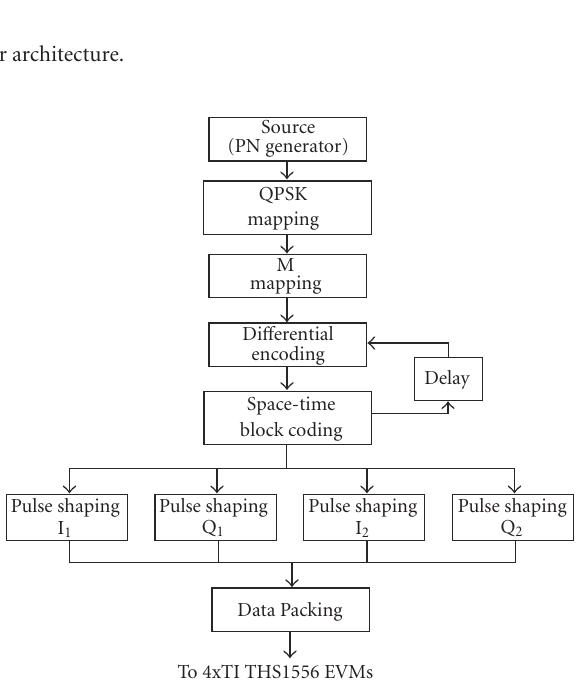
Figure 3: Transmitter software